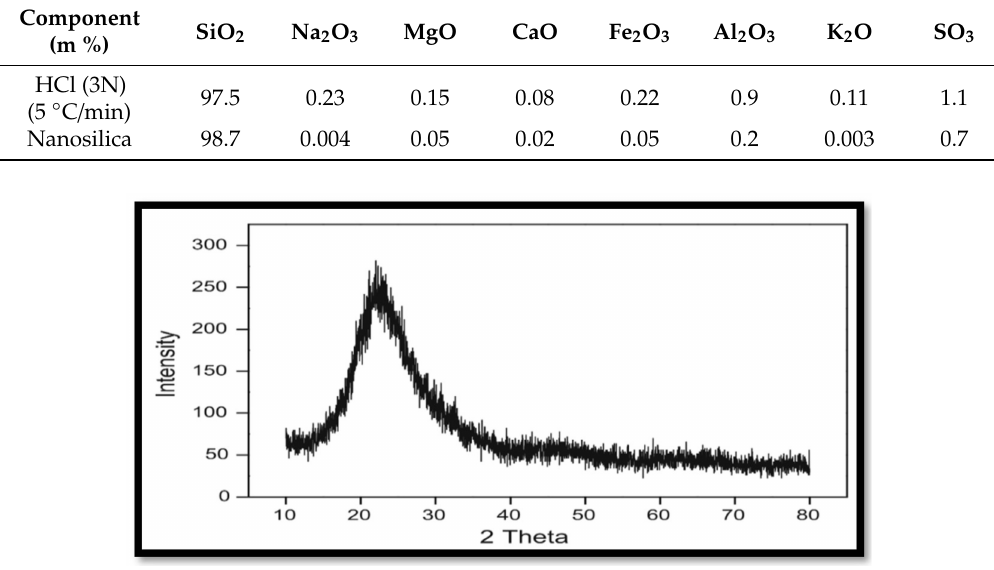
Figure 4. X-ray di ff raction pattern of the SiO 2